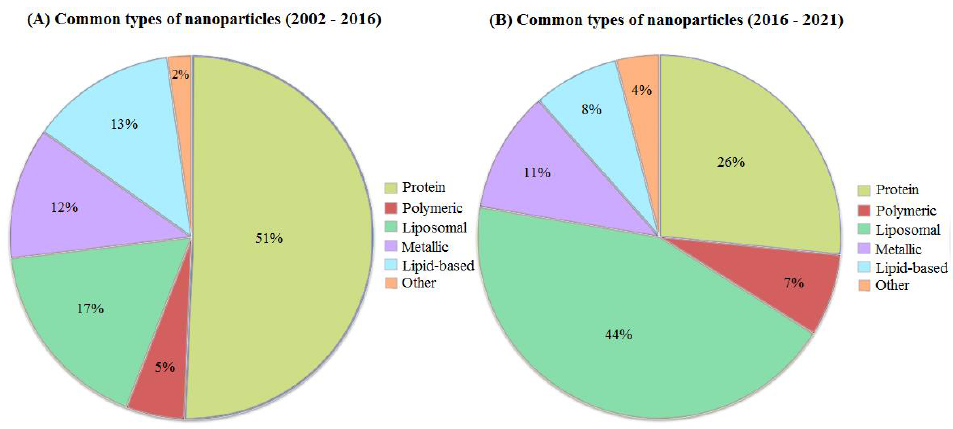
Figure 2. Common types of nanoparticles. This figure contains information about the types of nanoparticles used in clinical trials. ( A ) Pie chart A represents the types of nanoparticles in clinical trials from 2002 to 2016. The group other consists of carbon-based, silica-based nanoparticles and nanostructured formulations of hormones. In the 2002–2016 period, the most abundant type of nanoparticles in clinical trials was protein (51%). Liposomal formulations were the second most common but still relatively low (17%). Lipid-based nanoparticles could be encountered in 13% of all clinical trials in that period. Both metallic and polymeric formulations appeared to be scarce (12 and 5% respectively). ( B ) This part of the figure represents types of nanoparticles in trials from 2016 to 2021. The group other consists of quantum dots, micellar nanoparticles and exosomes. In comparison to 2002–2016, protein nanoparticles demonstrated a downfall (from 51% to 26%) which can be explained by an increase in liposomal drugs (from 17% to 44%). Lipid-based formulations also faced a slight decrease to 8%, while metallic and polymeric drug percentages stayed almost the same (11% and 7%, respectively).